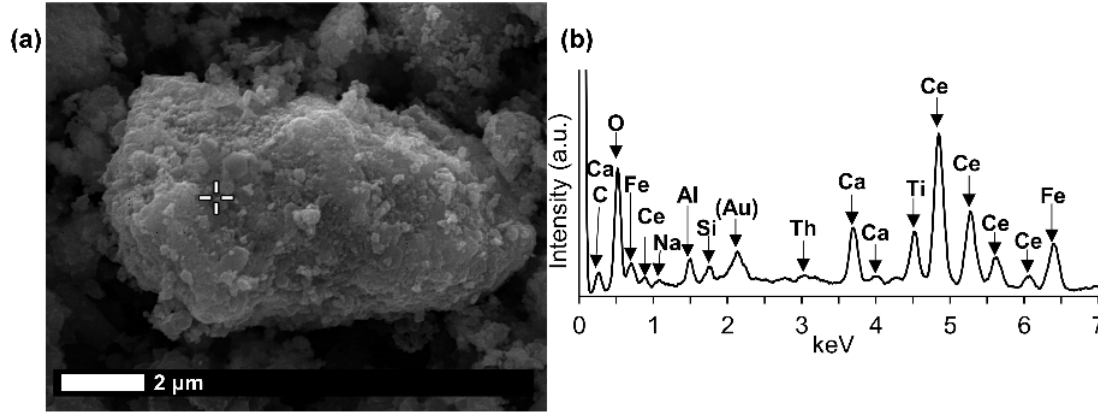
Figure 9. Cerium ferrotitanate particle shown on ( a ) secondary electron image with its ( b ) EDS spectrum; gold (Au) peak is from the coating layer on the sample.